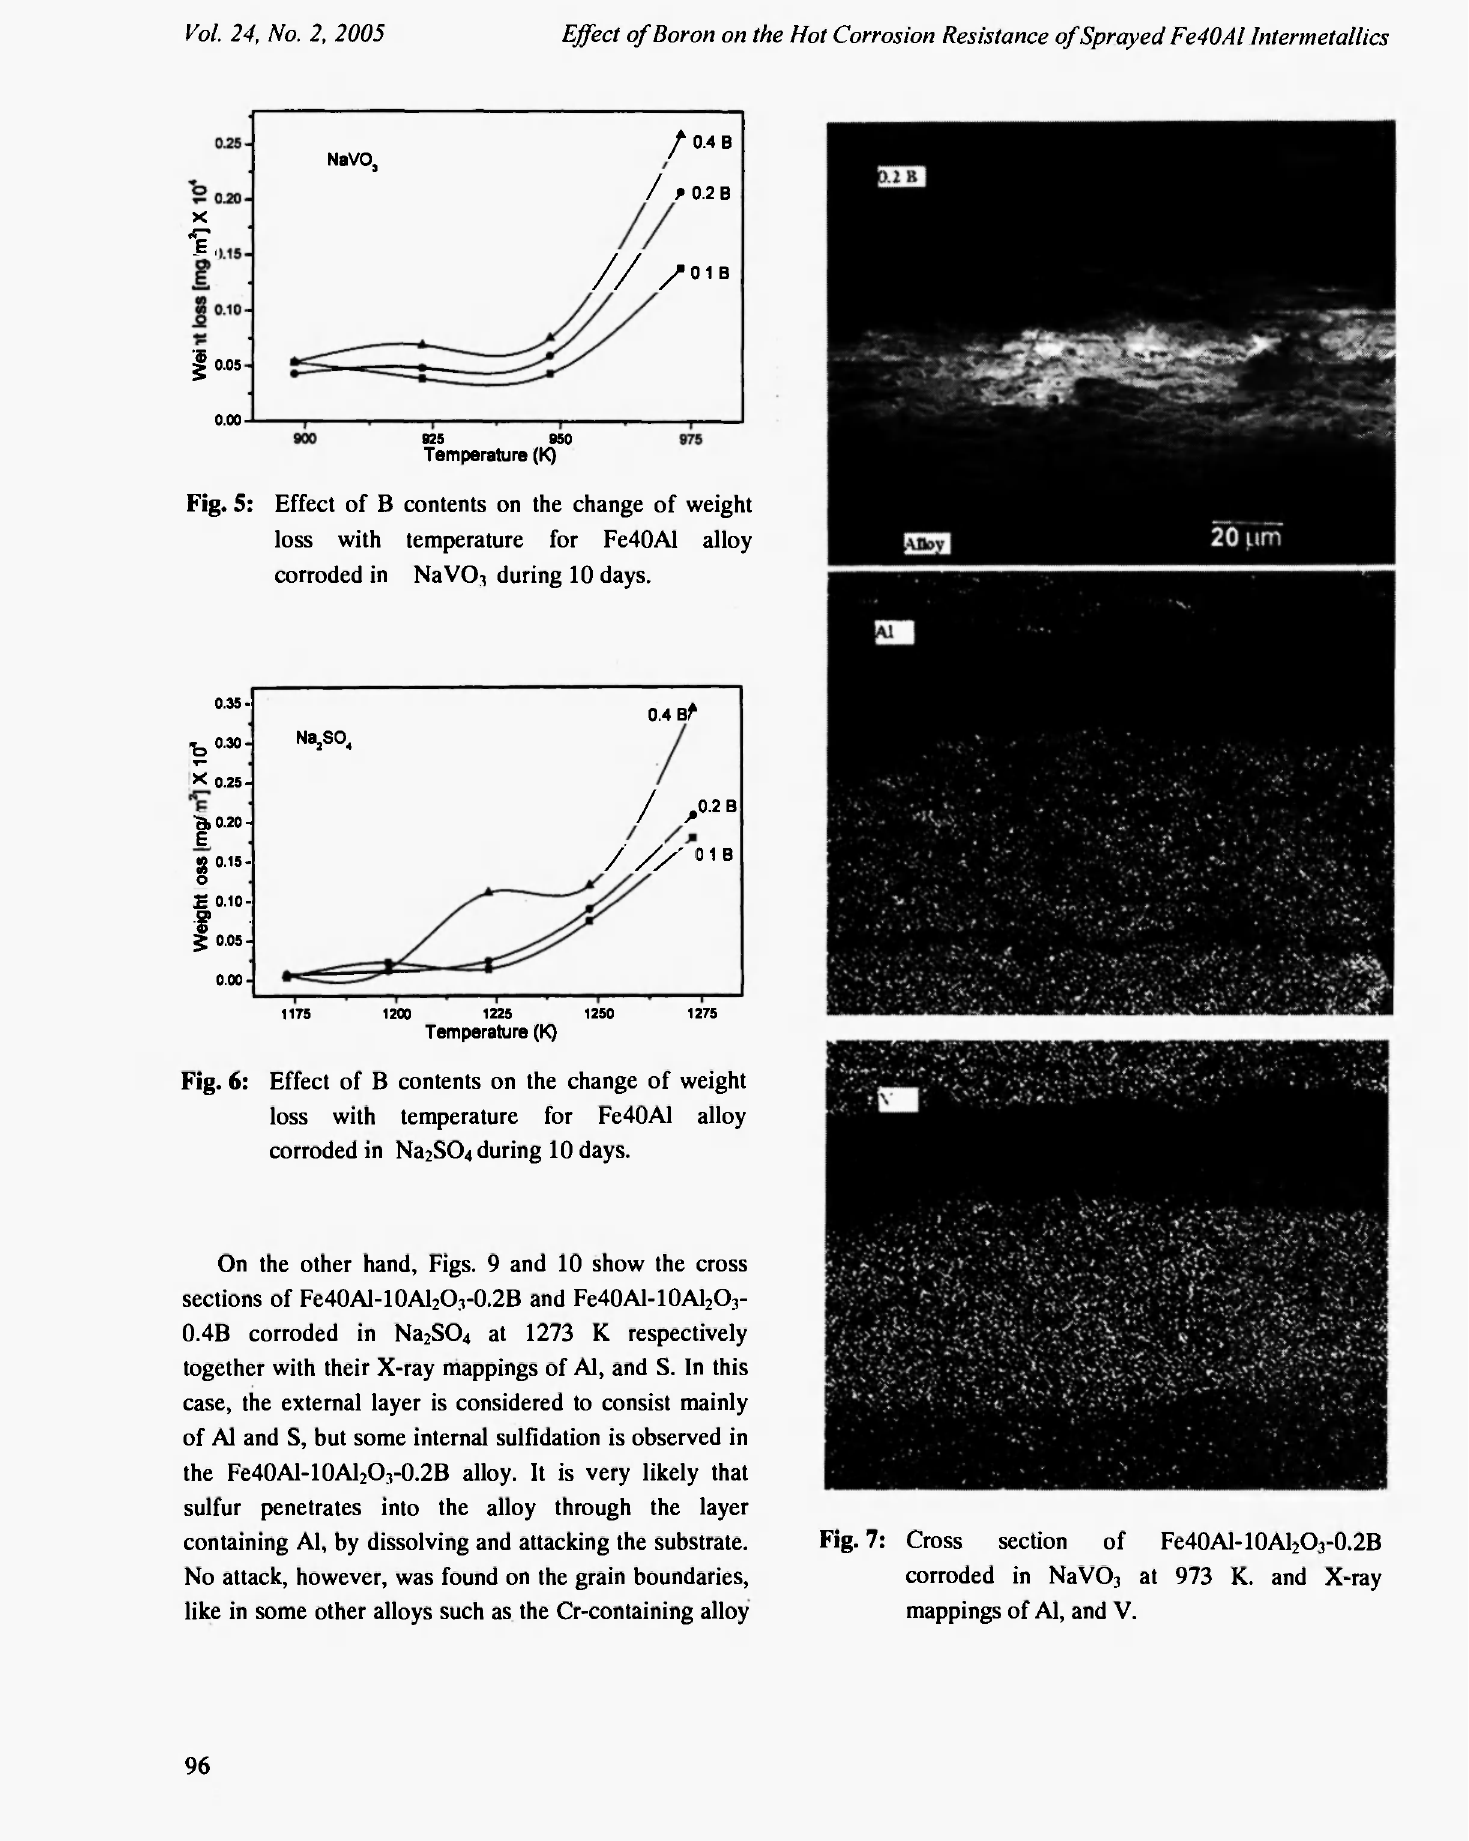
Fig. 7: Cross section of Fe40Al-10Al 2 0 3 -0.2B corroded in NaV0 3 at 973 K. and X-ray mappings of Al, and